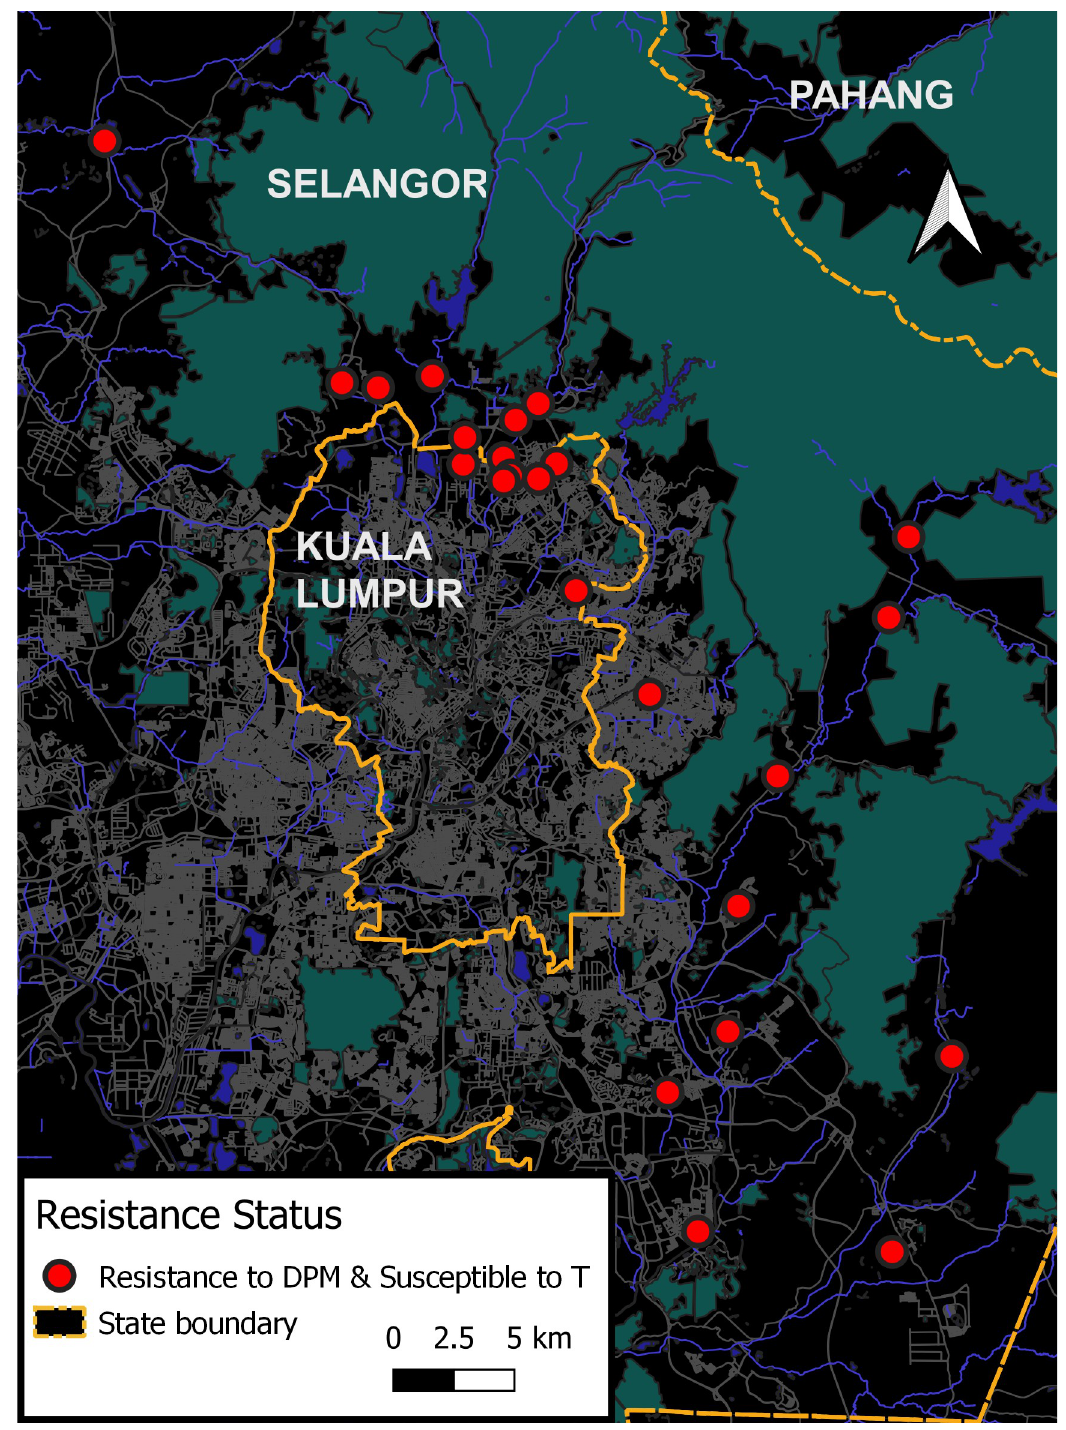
Fig 1. Insecticide susceptibility profile of Aedes aegypti populations. The code D,P,M, and T refers to deltamethrin, permethrin, malathion, and temephos, respectively.